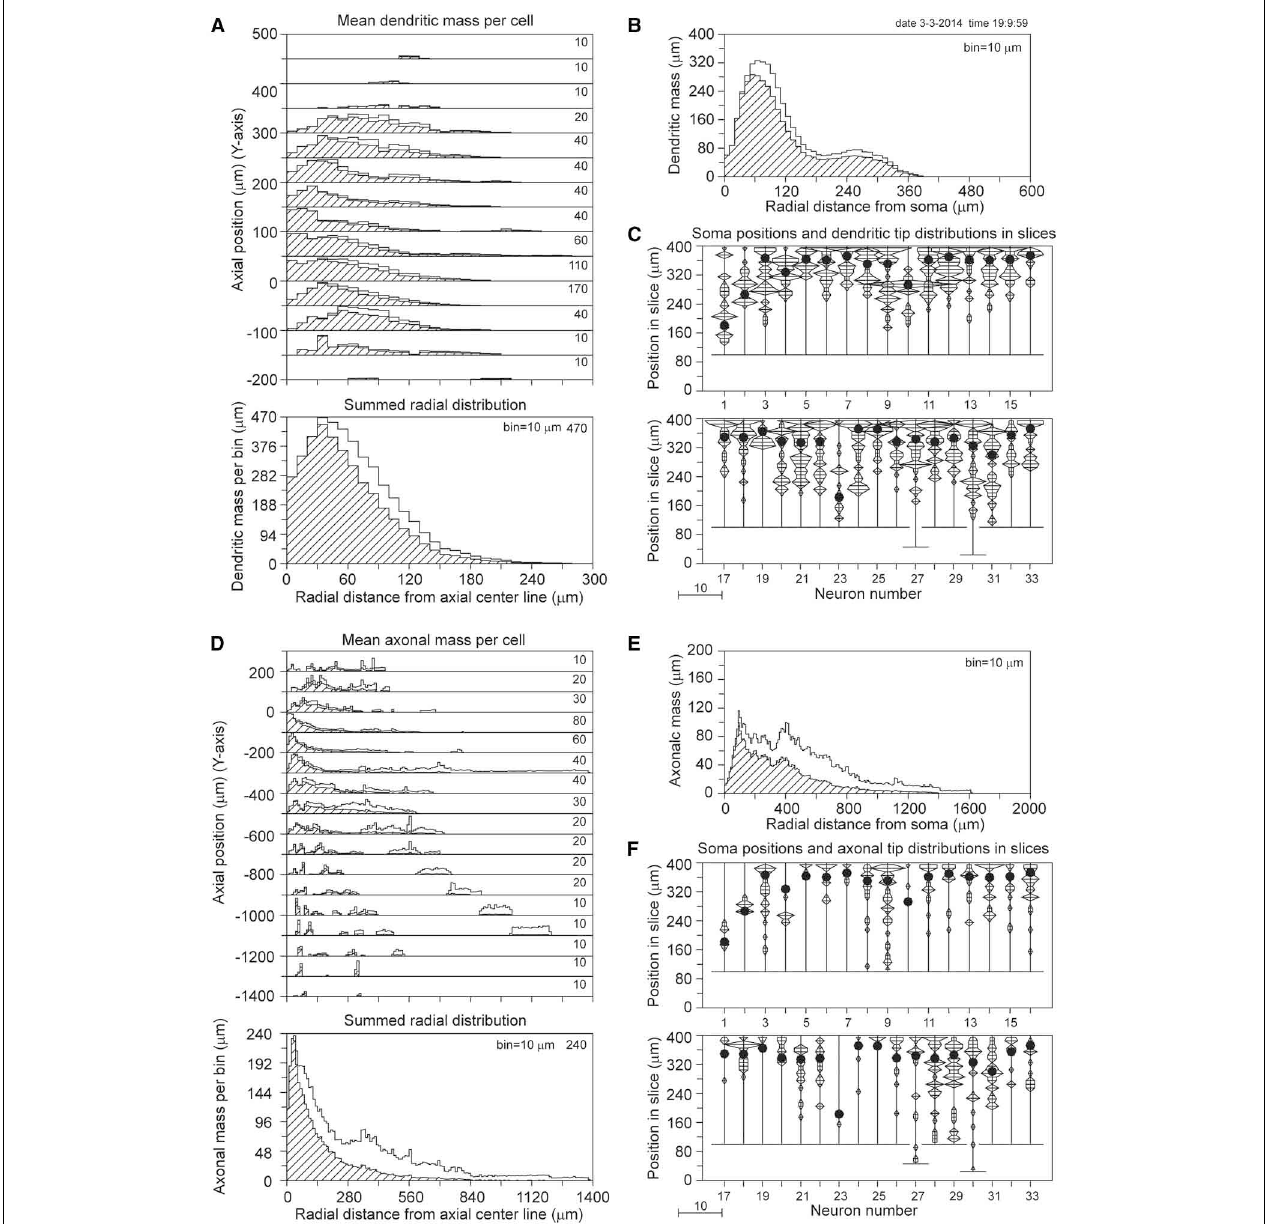
FIGURE 9 | Mass completion of 33 Wistar rat cortical L2/3 pyramidal neurons reconstructed from 300 µ m thick slices by Wang et al. (2002), and obtained from the NeuroMorpho.org database. For the description of the different panels see the legend of Figure 4 . Lacking information on the soma positions in the slices,